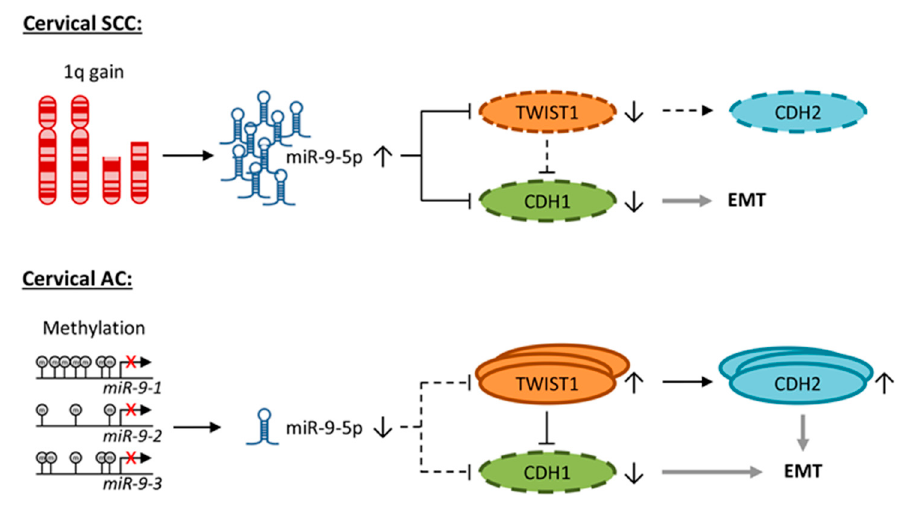
Figure 6. Concept of the effect of miR-9-5p on EMT in cervical cancer . TWIST1 and CDH1 are direct targets of miR-9-5p. TWIST1 inhibits transcription of CDH1 and promotes CDH2 expression. In cervical SCC, chromosomal gain of 1q causes miR-9-5p overexpression. Here, miR-9-5p inhibits translation of TWIST1 and CDH1 and low expression of CDH1 promotes epithelial-to-mesenchymal transition (EMT). In cervical AC, miR-9-5p expression is low due to promoter methylation of its precursor genes, particularly miR-9-1 . TWIST1 is not inhibited by miR-9-5p and mediates suppression of CDH1, as well as upregulation of CDH2, thereby promoting EMT.